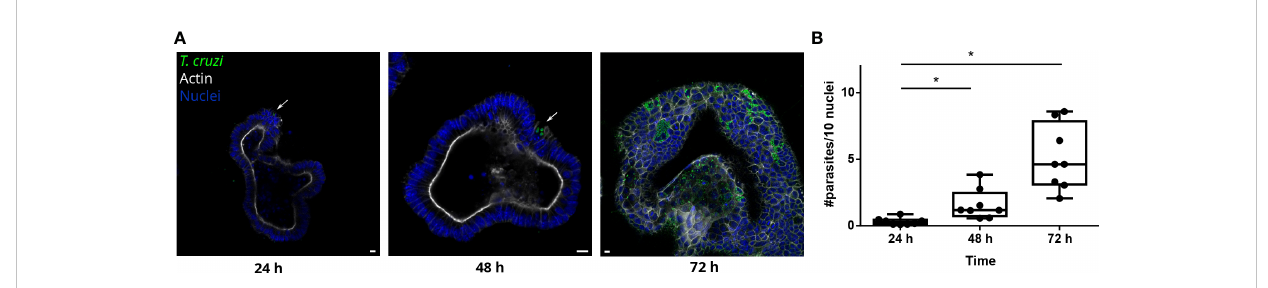
FIGURE 3 T. cruzi is able to invade and replicate inside organoids. (A) Representative images of organoids infected with parasites (MOI 1:15) and incubated for 24, 48 or 72 h. Arrows indicate infected cells. (B) Number of intracellular parasites every 10 cells at different time points. Data from one representative experiment out of 2 independent experiments (different organoid lines per experiment). Data are expressed as median and interquartile range and compared using Mann-Whitney test (n = 8) p<0.05. Scale bar: 10 m m. Nuclei (blue): Hoechst 33342 staining, T. cruzi (green): anti-trypanothione reductase immune-staining, and Actin (white): phalloidin Texas Red staining. *p<0.05.